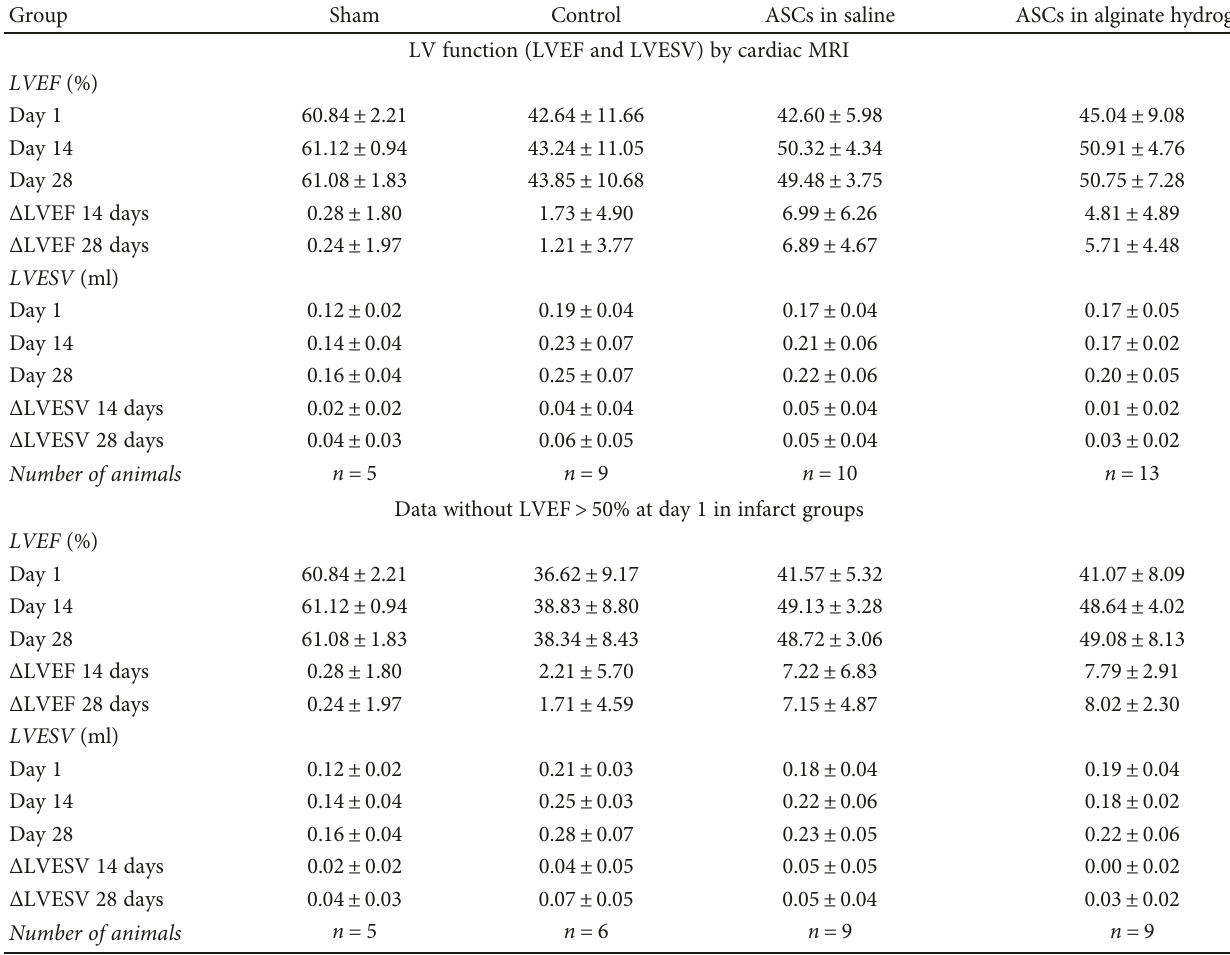
Table 1: Treatment e ff ect on left ventricular (LV) function by cardiac